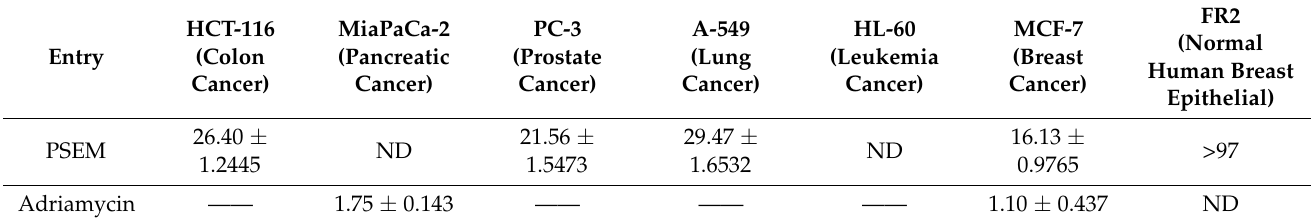
Table 5. IC 50 values of chloroform extract against different human cancer and normal cells.